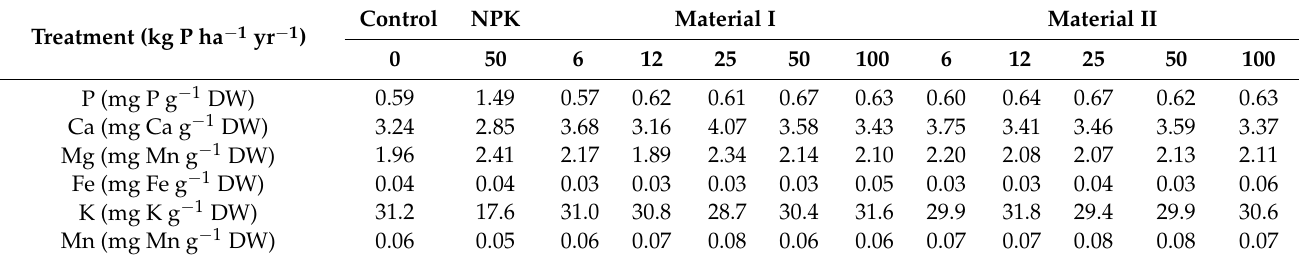
Table 3. Mineral element concentrations in Zea mays biomass. Phosphorus (P) was added as P-enriched material (I or II) with five P levels (6, 12, 25, 50, 100 kg P ha − 1 yr − 1 ). The control treatment had no P supplied and the NPK fertilizer treatment had a P supply corresponding to 50 kg P ha − 1 yr − 1 . The biomass was harvest and divided into biomass fractions and element concentrations were analyzed in all biomass fractions. Values are averages ( n =